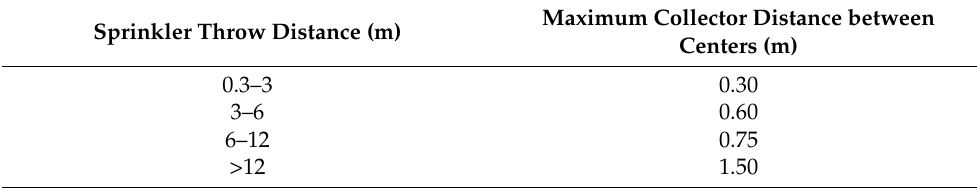
Figure 1. Schematic diagram representing the distribution of catch cans. Table 1. Spacing of collectors according to the ASAE Standard [38]. Sprinkler Throw Distance (m)